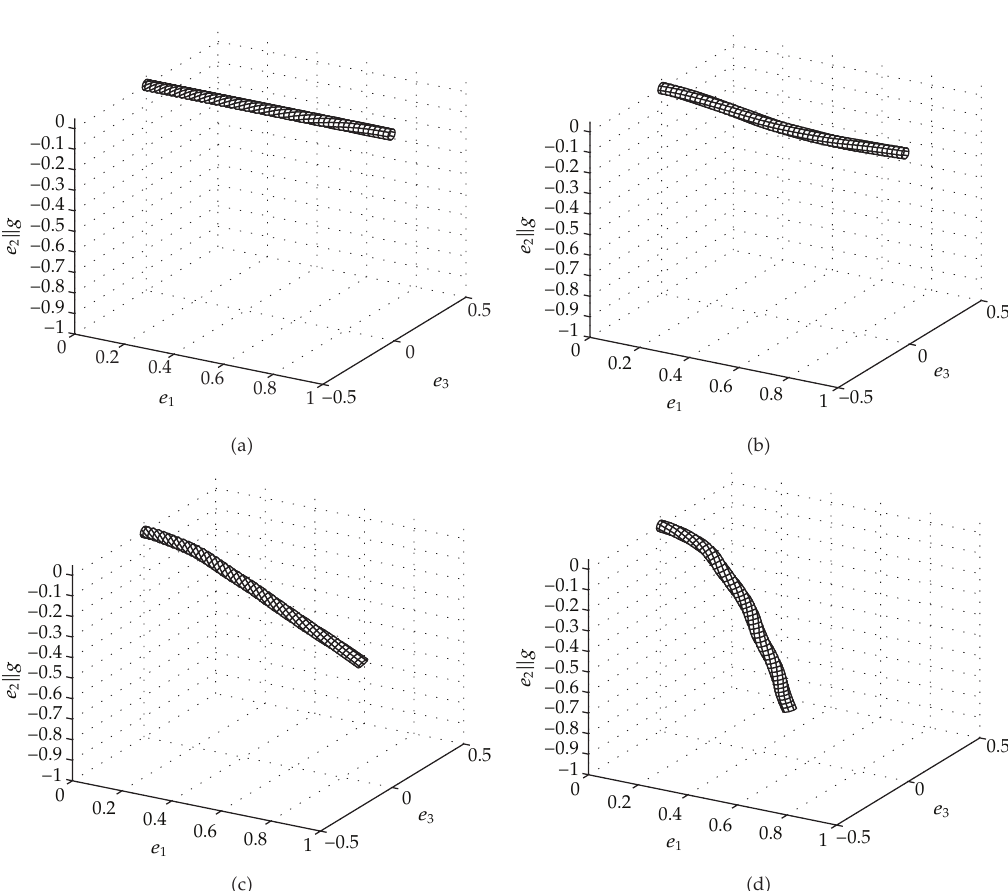
Figure 4: Rod’s curve at t (cid:7) 0 (cid:5) a (cid:6) , t (cid:7) 40 (cid:5) b (cid:6) , t (cid:7) 80 (cid:5) c (cid:6) , and t (cid:7) 120 (cid:5) d (cid:6)